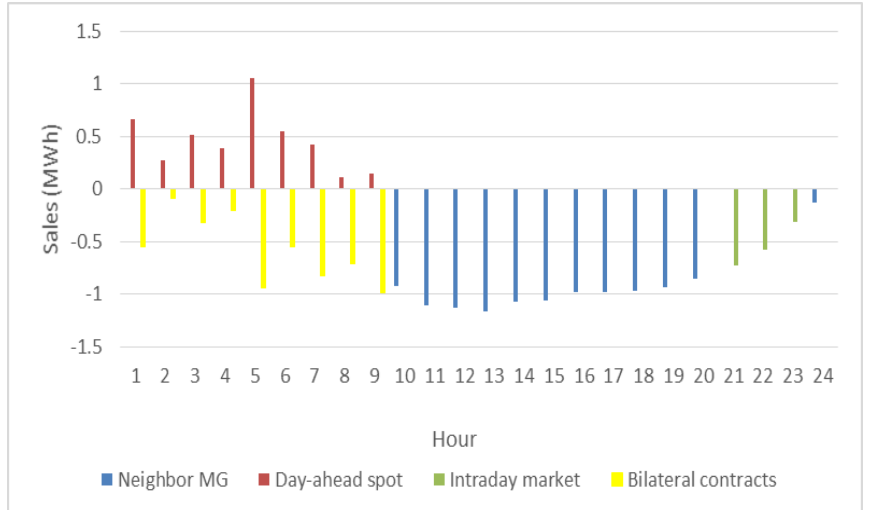
Figure 10. Negotiation scheduling for MGCC 3.